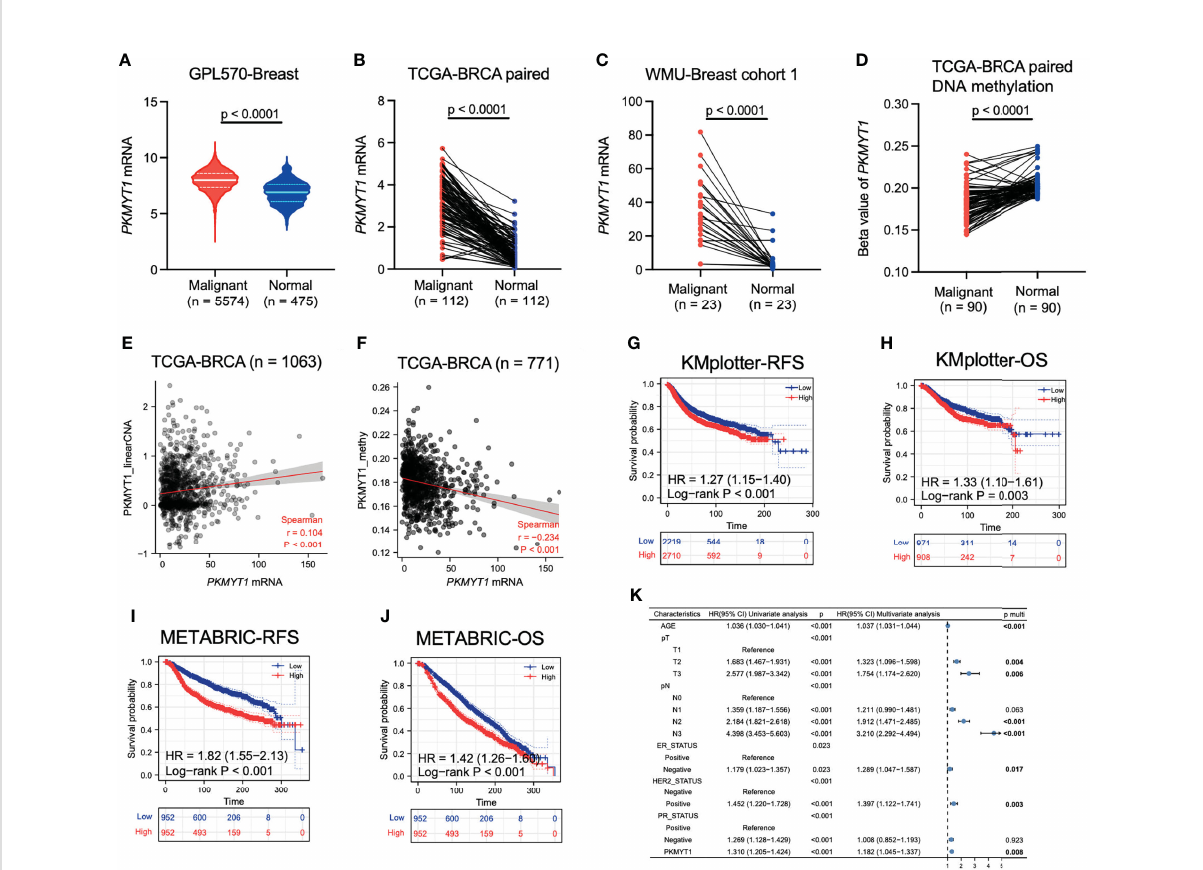
FIGURE 1 Analysis of multi-omics data showed that PKMYT1 was over-expressed in BC and could serve as an independent prognostic marker. (A, B) The PKMYT1 mRNA expression levels in BC microarray data and paired TCGA-BRCA cohort; (C) The mRNA expression levels of PKMYT1 in local cohort sample; (D) DNA methylation levels of PKMYT1 between BC and normal tissues were analyzed using HM450 chip sequencing data of TCGA-BRCA cohort; (E, F) The correlation between PKMYT1 mRNA expression level and PKMYT1 copy number variation or methylation level in TCGA-BRCA cohort; (G – J) Kaplan-Meier analysis for RFS and OS of BC patients in the KM-plotter cohort and METABRIC cohort; (K) Univariate and multivariate Cox regression analysis for OS of BC patients in METABRIC